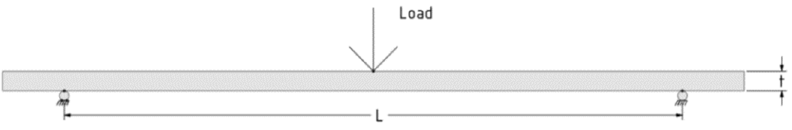
Figure 1. Three-point bending diagram.